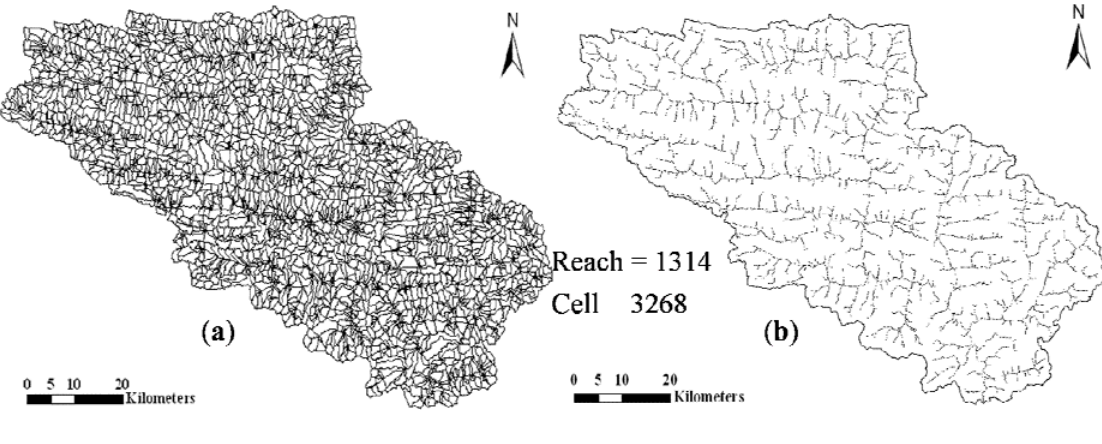
Figure 8. Generated subwatersheds and stream network of the study